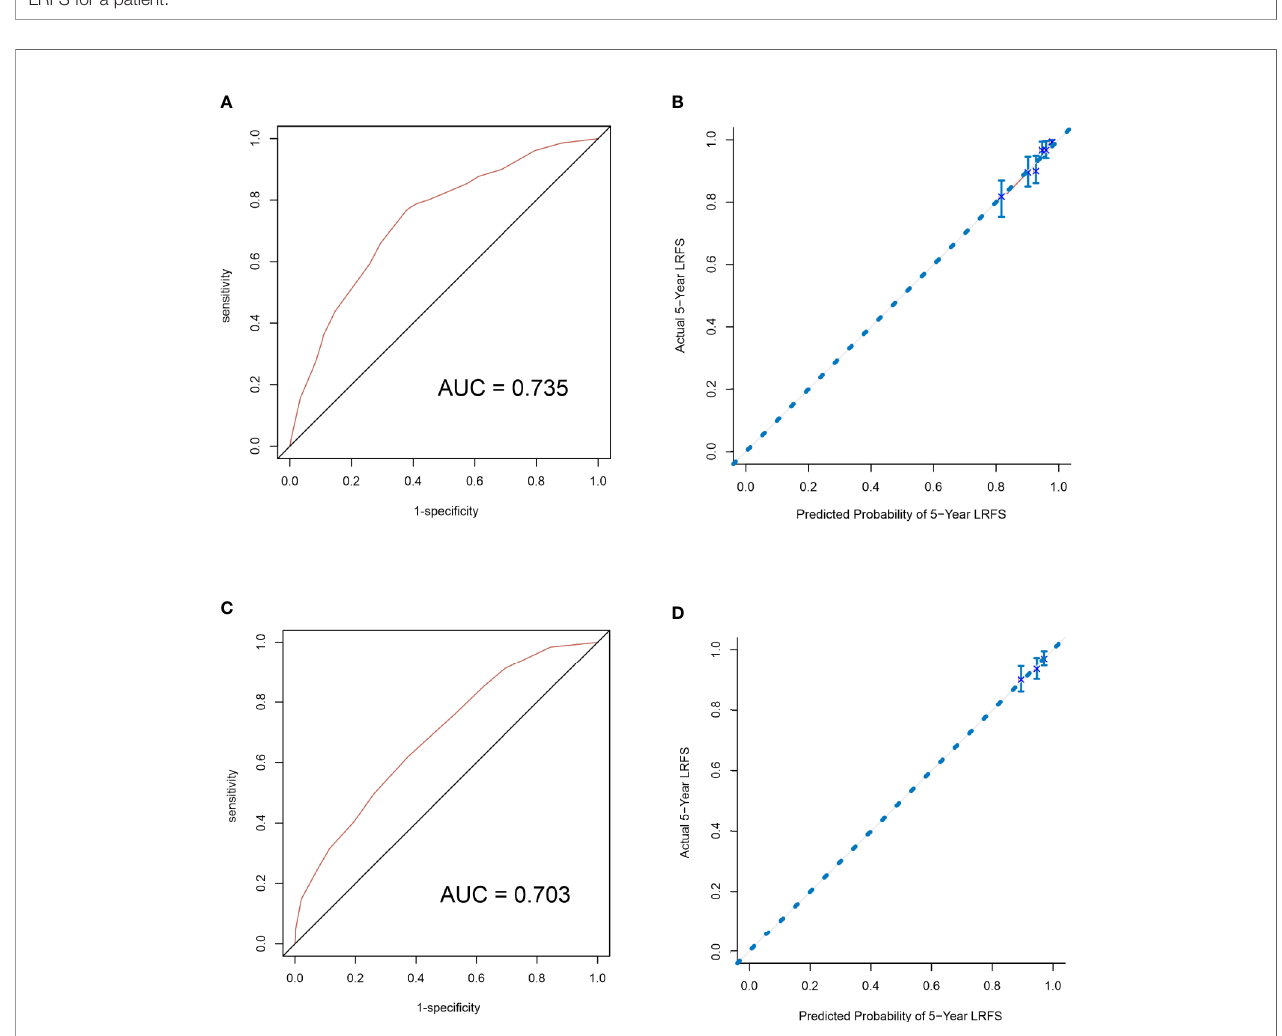
FIGURE 2 | Internal validation of the nomogram to predict LRFS likelihoods in the primary cohort patients. The area under the receiver operating characteristic (ROC) curve (AUC) was 0.735 (A) . The calibration curve for the prediction of 5-year LRFS (B) . External validation of the nomogram to predict LRFS likelihoods in the validation cohort patients. The area under the receiver operating characteristic (ROC) curve (AUC) was 0.703 (C) . The calibration curve for the prediction of 5-year LRFS (D)